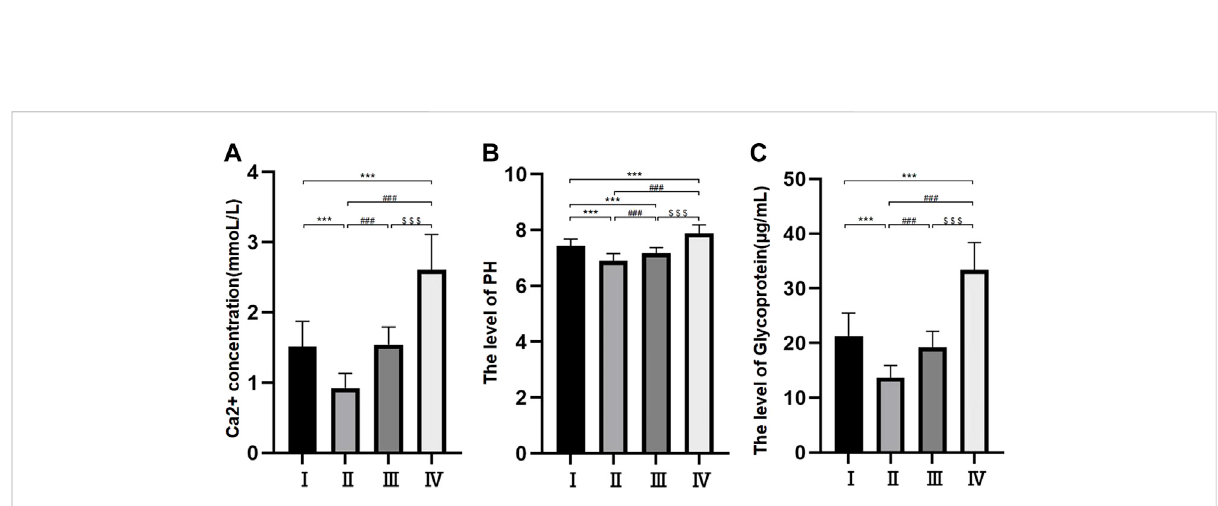
TABLE 3 The level of bile acids of different